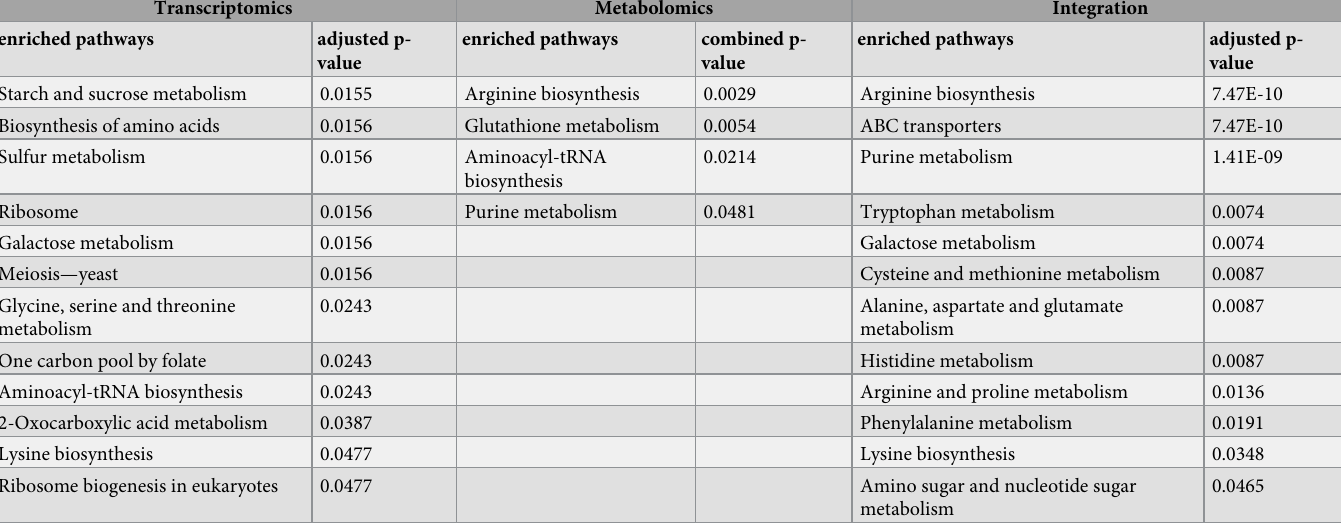
Table 3. Single- and multi-omics integration results for asc1 by concentration analysis. First block shows GSEA for transcriptomics with adjusted p-value < 0.05, arranged in ascending order; second block shows MetaboAnalystR pathway enrichment analysis for metabolomics with combined p-value < 0.05, arranged in ascending order; third block shows MetaboAnalystR joint pathway analysis with adjusted p-value < 0.05, arranged in ascending order, as detailed in